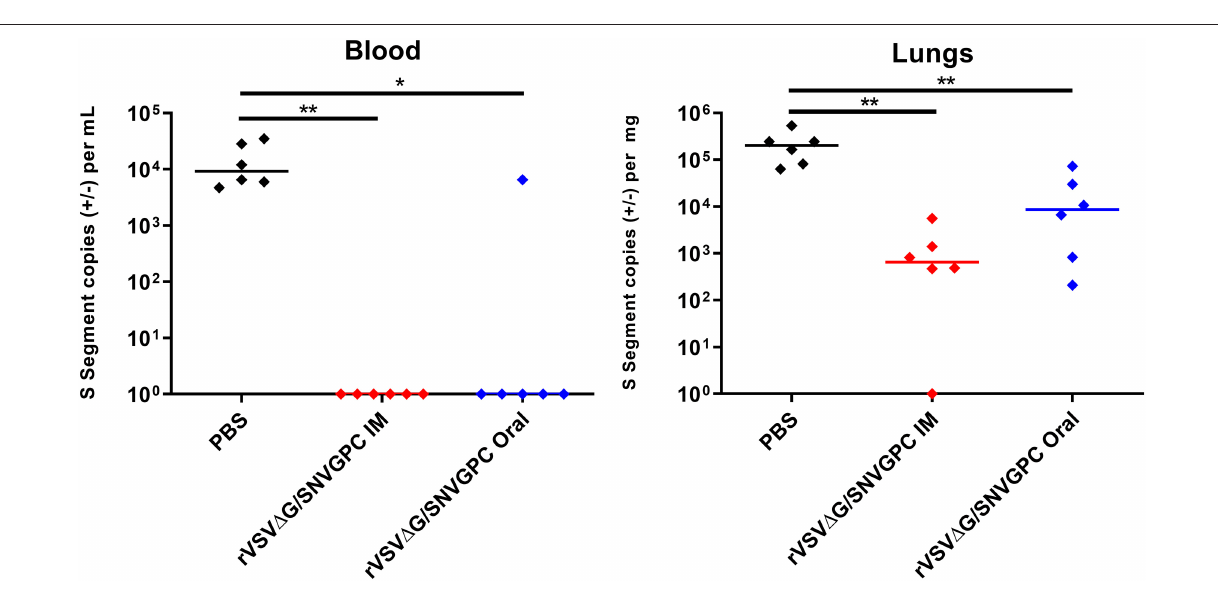
FIGURE 2 | Protective efficacy of rVSV 1 G/SNVGPC vaccination in deer mice. Vaccinated deer mice were infected with SNV 28 days following vaccination and SNV RNA levels were detected in the blood and lungs of infected mice 14 days post-infection. Shown are data medians. n = 6 Statistical significance assessed by Mann-Whitney test. * p < 0.05, ** p <